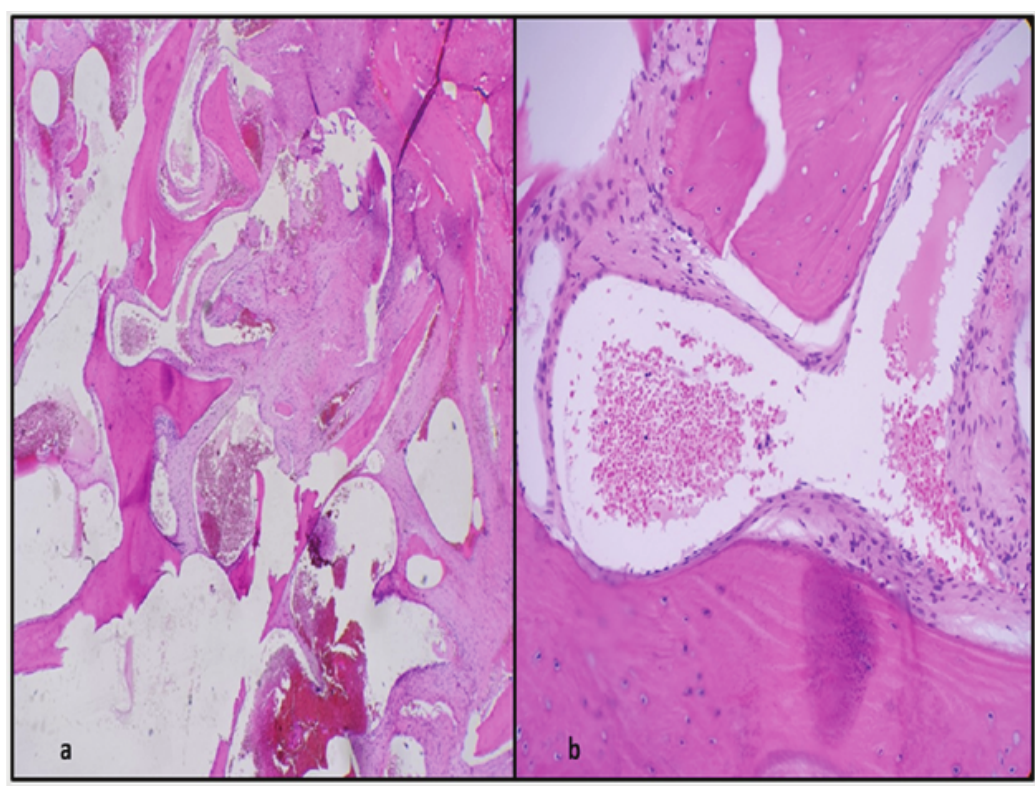
Figure 2 : Section from the affected bone showing variably sized, dilated blood vessels, lined by bland endothelial cells surrounded by stroma made of spindle cells encased by lamellar bone trabeculae (Hematoxylin and Eosin: Ax 20X, Bx